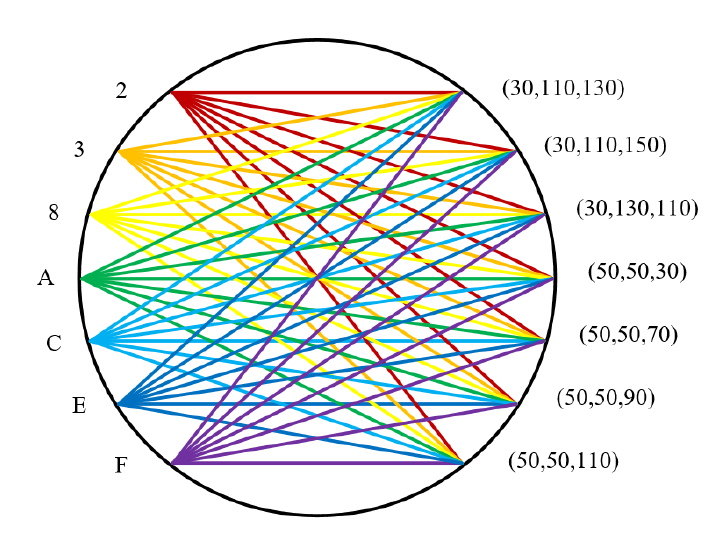
Figure 15. Mapping graph with dynamic transition